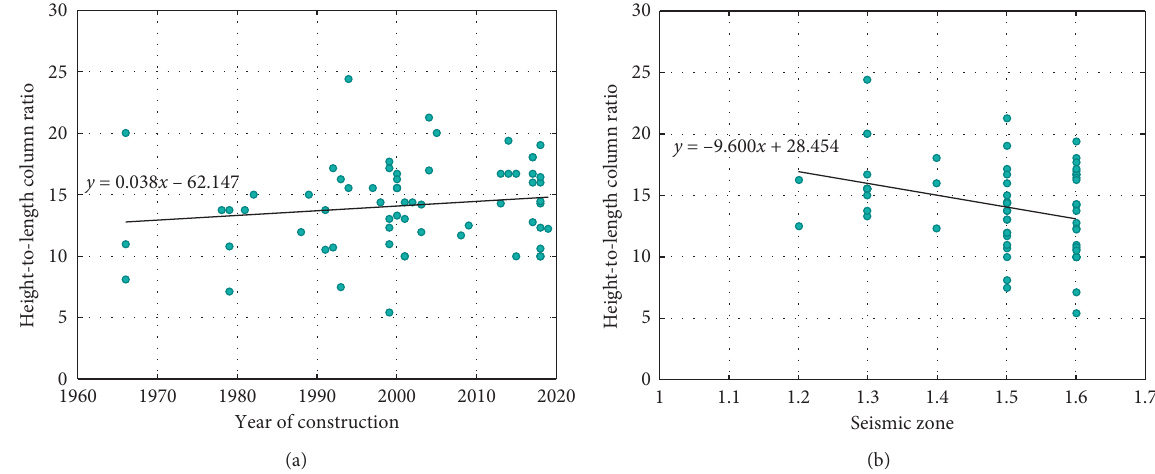
Figure 20: Evolution of height-to-column ratio with the (a) year of construction and (b) seismic zone.